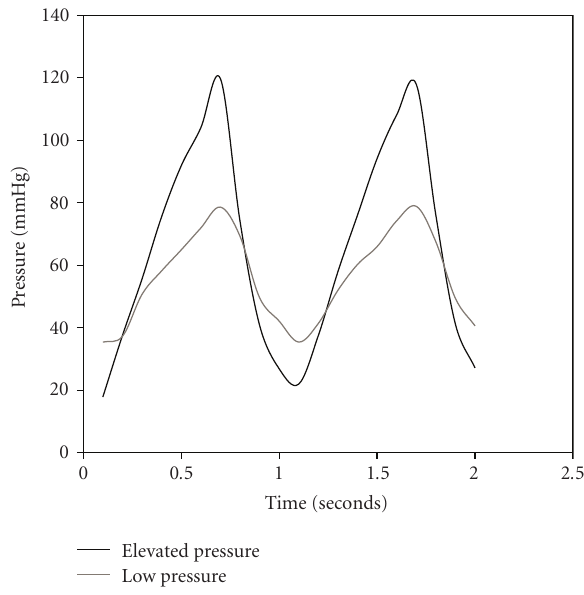
Figure 3: Pressure waveforms generated from the pressure system.